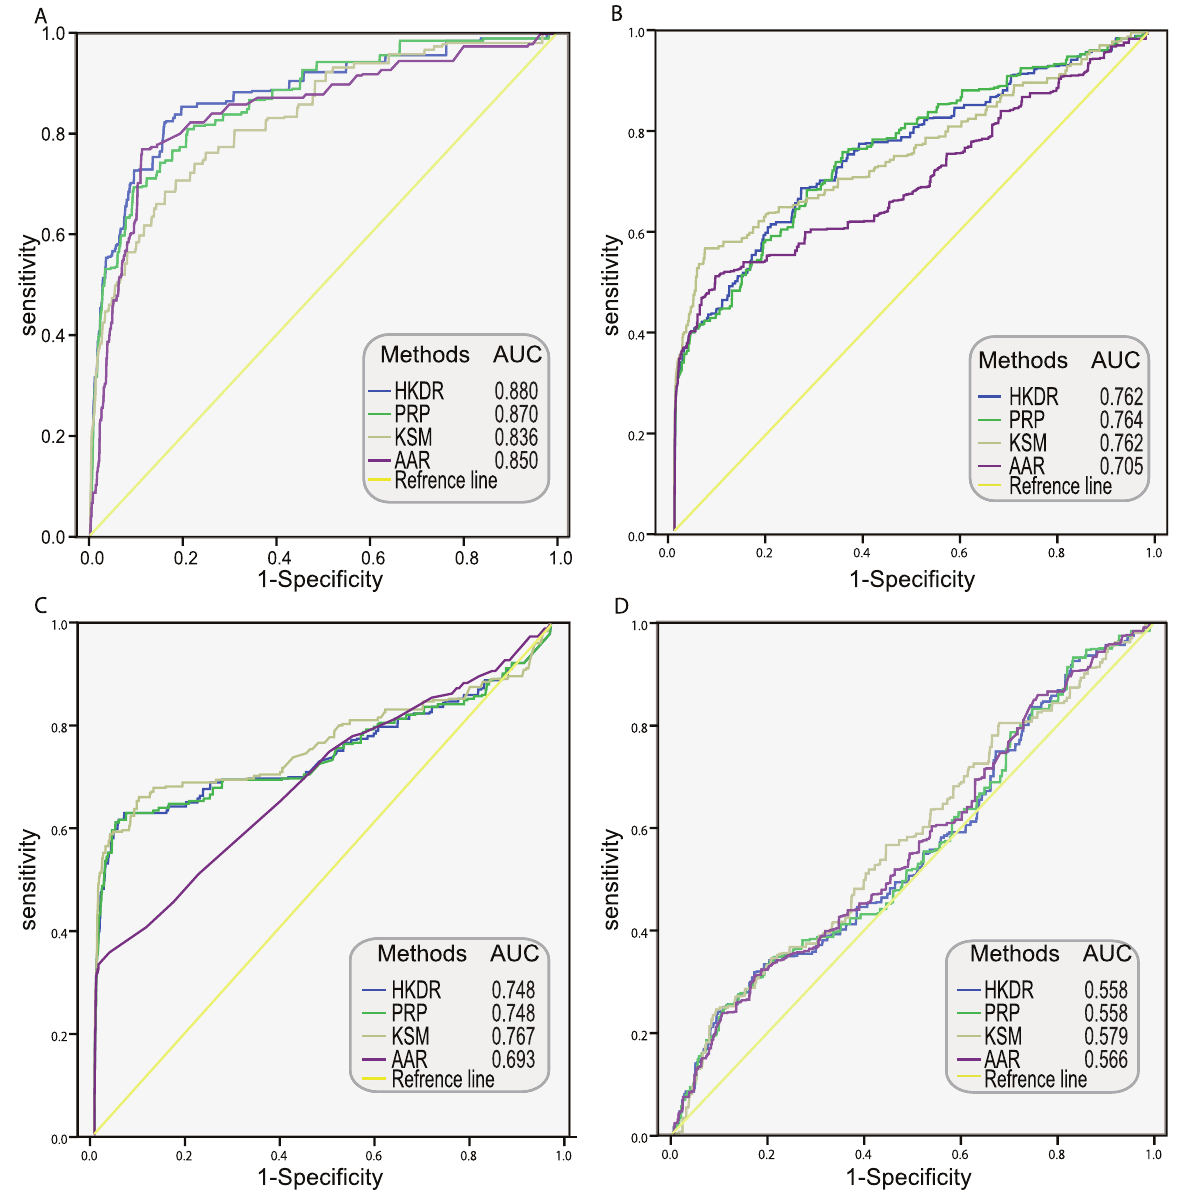
Figure 5. ROC curves for evaluating the performances of four networks on disease-gene prioritization. (A) The ROC curve for FLN. (B) The ROC curve for FLNhm. (C) The ROC curve for PPI network. (D) The ROC curve for co-expression network. AAR: Average Adjacency Ranking; PRP: PageRank with Priors; KSM: K-Step Markov; HKDR: Heat Kernel Diffusion Ranking; FLN: Functional Linkage Network among high-confidence mitochondrial proteins; FLNhm: Functional Linkage Network among high-confidence and middle-confidence mitochondrial proteins; PPIN: Protein- Protein Interaction Network; CEN: Co-Expression Network.